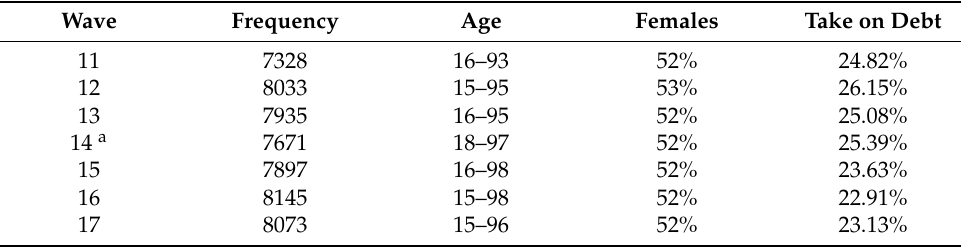
Table A1. Summary statistics of the unbalanced panel for a robustness check.